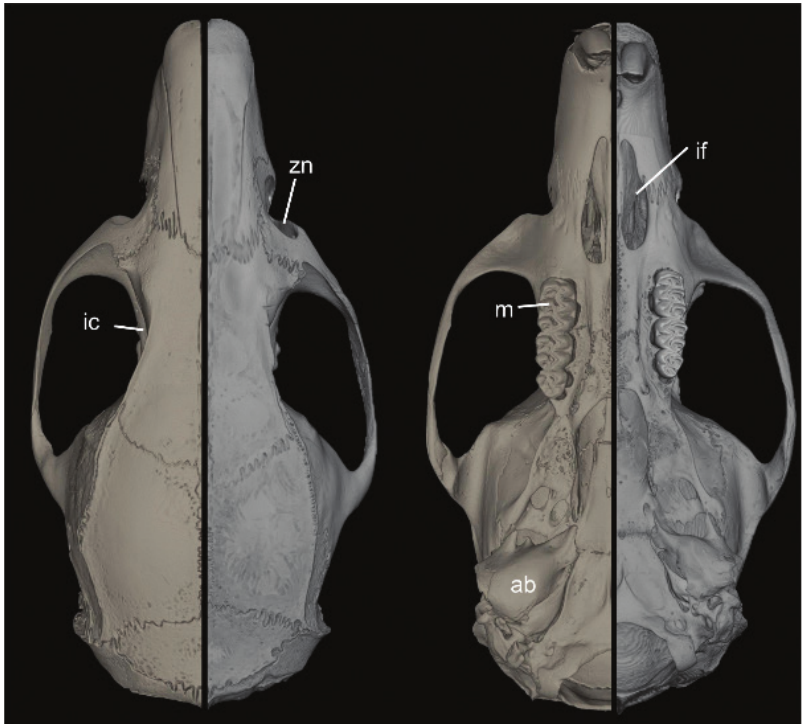
Figure 11. Three-dimensional reconstructions of selected aspects of qualitative anatomy contrasted in the crania (dorsal view to the left, ventral view to the right) based on micro-CT data of the holotypes of Mindomys kutuku sp. nov. (left; MECN 5809; Cordillera de Kutukú, Ecuador) and Mindomys hammondi (right; NHMUK 13.10.24.58; Mindo, Ecuador), scaled to the same length. The fig - ure portrays differences between the characteristics of these species as follows: M. kutuku sp. nov. has shallower zygomatic notch (zn), posteriorly displaced interorbital constriction (ic), longer incisive foramina (if), larger molars (m), larger auditory bulla (ab), and more caudally directed foramen magnum. Figures are not to scale to facilitate